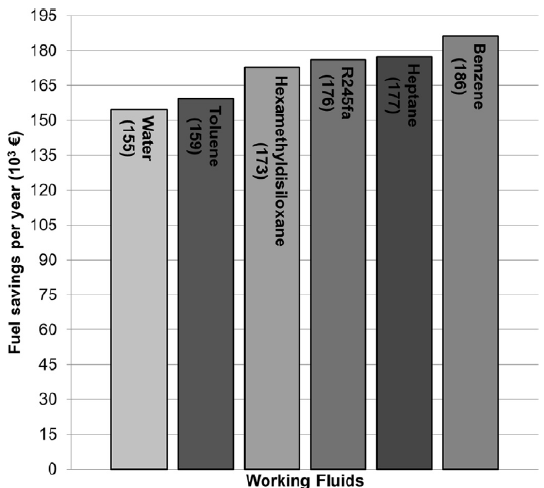
Figure 20. Fuel savings per year for different WHR working fuels. Reprinted with permission from ref. [102]. Copyright © 2016 Elsevier Ltd. All rights reserved.